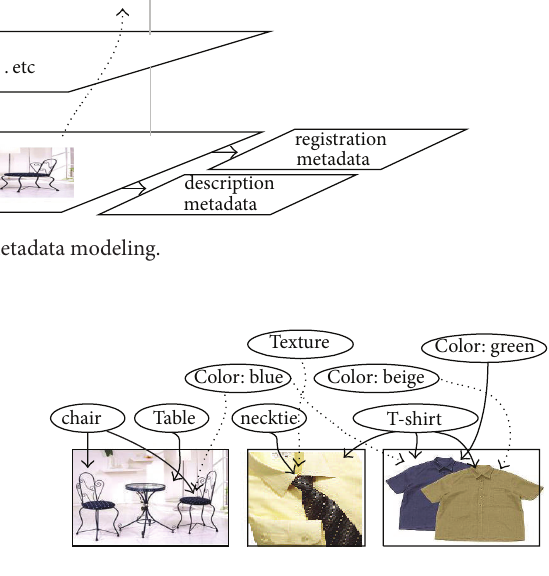
Figure 5: Examples of web e-catalog